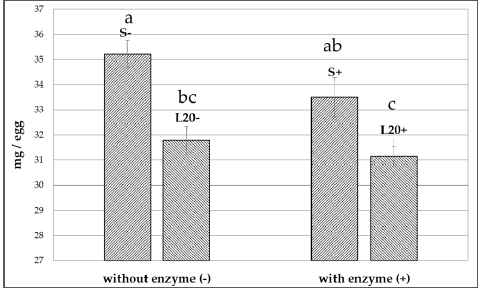
Figure 1. Influence of enzymes addition in lupine-based diets on the cholesterol content of quail eggs. a–c: bars with no common letters differ significantly ( p < 0.05). S − : standard diet without enzymes; S+: standard diet with enzymes; L 20 − : experimental diet (200 g/kg lupine) without enzymes; L 20 +: experimental diet (200 g/kg lupine) with enzymes.